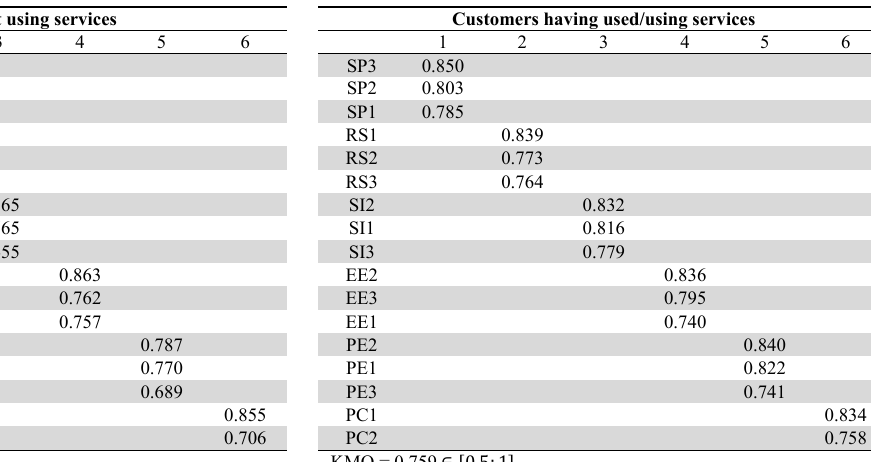
Factor rotation